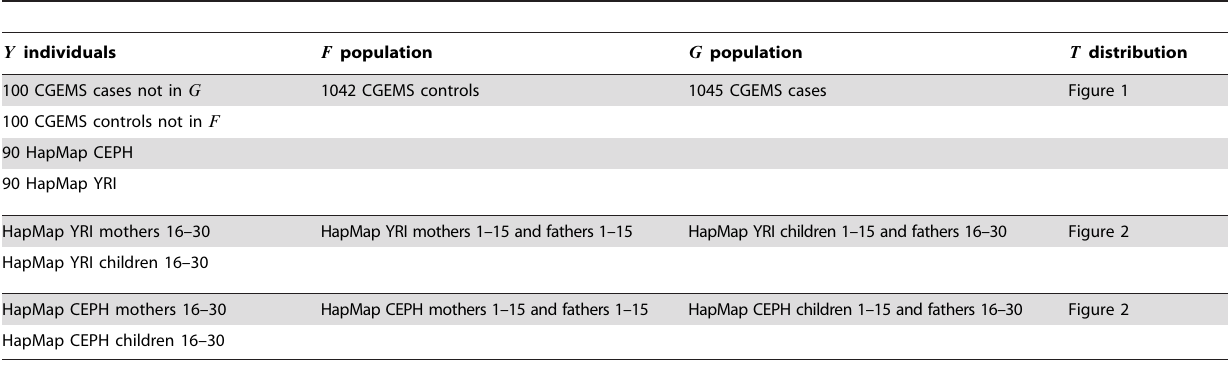
Table 1. Summary of tests